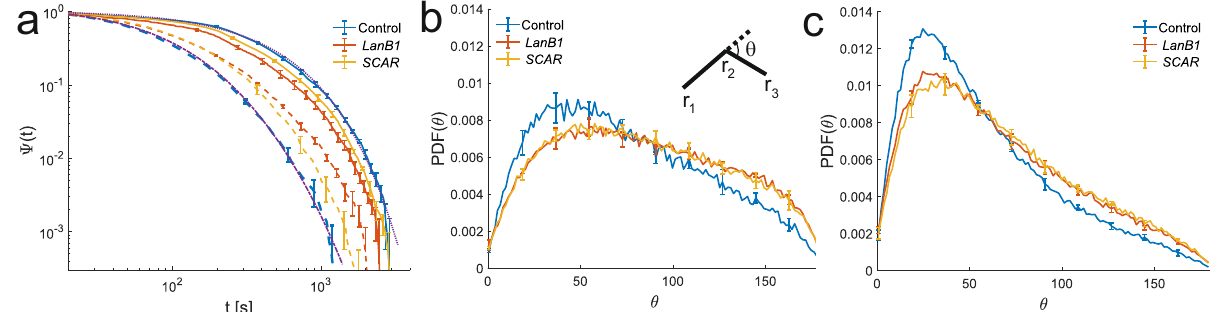
Fig. 2 Hemocytes move less persistently in mutant embryos. a Survival functions Ψ ( t ) of the times hemocytes move in persistent (solid curves) and anti- persistent (dashed curves) motion in the control (blue), LanB1 and SCARLanB1 (red) and SCAR (yellow) embryos are truncated power-laws. The error bars correspond to standard error of the mean. The dashed-doted and dotted curves are truncated power-law fi ts given by ( a /( a + t )) b e − ct with a = 300, b = 3.3, c = 0.0016 and a = 405, b = 0.33, c = 0.002, respectively. During anti-persistent periods of motion, cells change direction more often than during persistent periods. This is con fi rmed by the form of PDFs of angles θ ¼ arccos ð d r 1 (cid:2) d r 2 = j d r 1 jj d r 2 jÞ , where d r 1 = r 2 − r 1 and d r 2 = r 3 − r 2 are displacement vectors (see the inset in ( b )) for anti-persistent ( b ) and persistent periods of motion ( c calculated the survival functions of the times the hemocytes spent increases in LanB1 and SCAR embryos compared to the control. in persistent and anti-persistent states (Fig. 2a) using the non- This agrees with the visual inspection of trajectories in Fig. 1a – c. parametric Kaplan-Meier estimator 38 . Survival analysis revealed During persistent periods of motion, hemocytes change their that the majority of hemocytes spent longer in persistent than direction of motion less than during anti-persistent periods of anti-persistent states. The duration of anti-persistent motion motion (Fig. 2b, c). The reduction of persistence of the movement